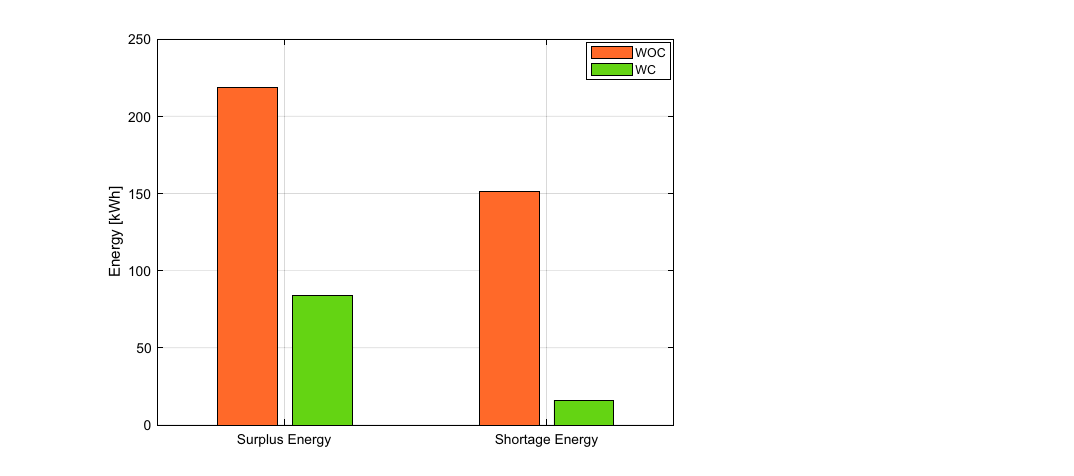
Figure 7. Minus and extra energy throughout the day.